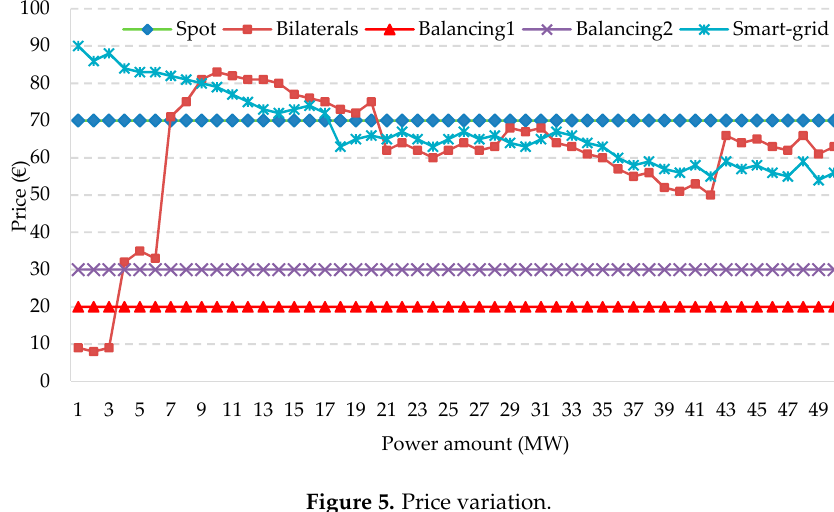
Figure 5. Price variation.